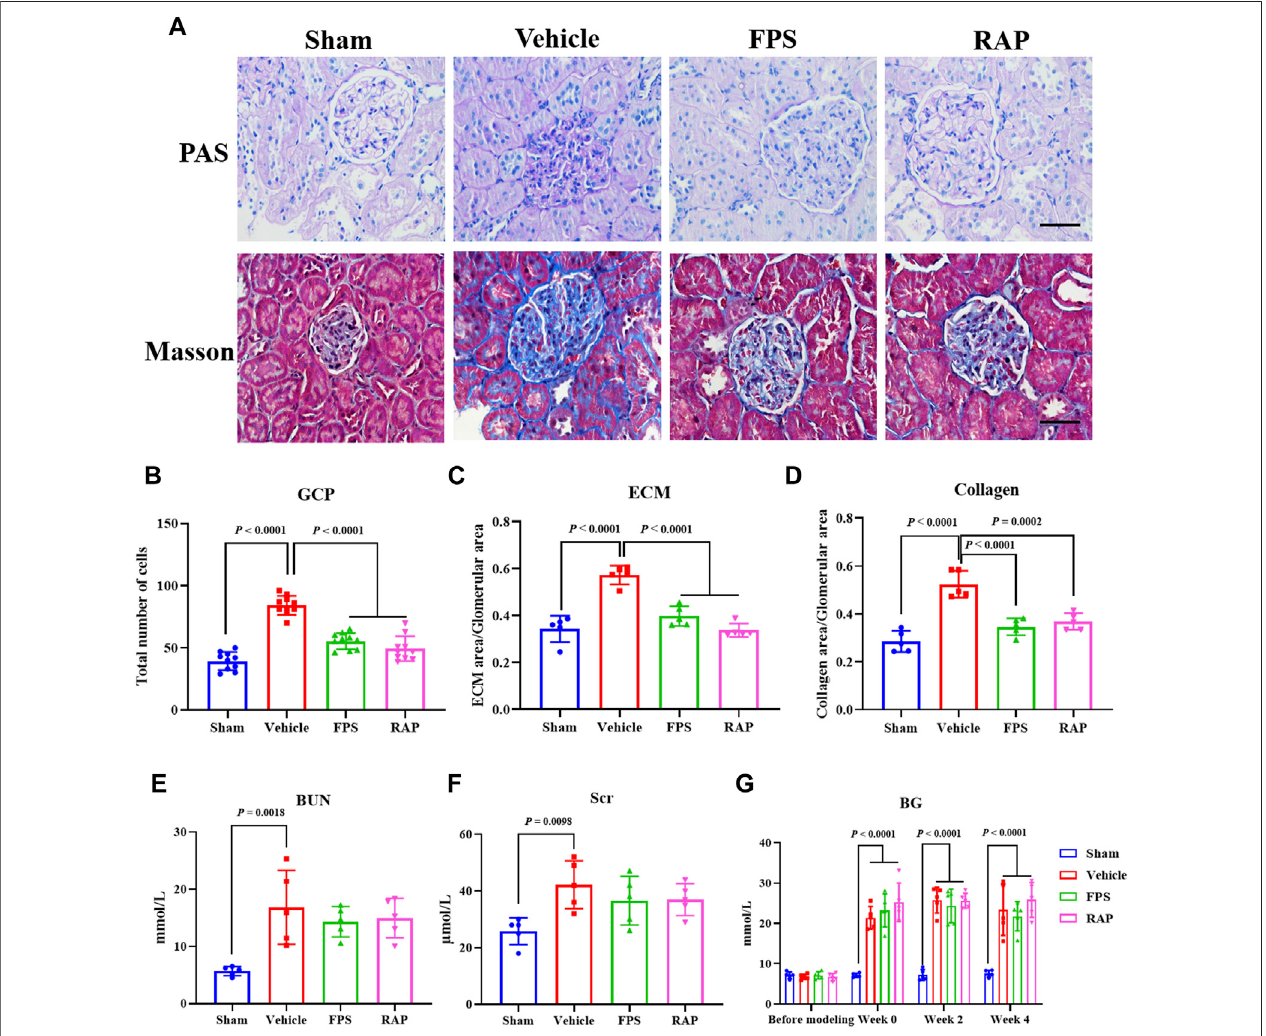
FIGURE1 | Effects of FPSand RAPon GSand renalfunction invivo . (A) The staining ofPASand Masson stains in thediabetickidneys (×400). Scale bar = 50 μ m. (B) The number of GCP. (C) The rate of ECM area/glomerular area. (D) The rate of collagen area/glomerular area. (E,F) The levels of Scr and BUN. (G) The dynamic changes in BG after drug intervention during 4 weeks. The data are expressed as the mean ±